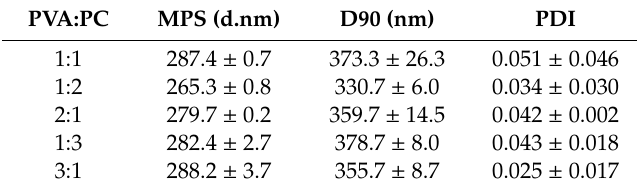
Table 1. E ff ects of complex surfactants on the MPS, D90, and PDI of the nanocapsules. Table 1. Effects of complex surfactants on the MPS, D90, and PDI of the